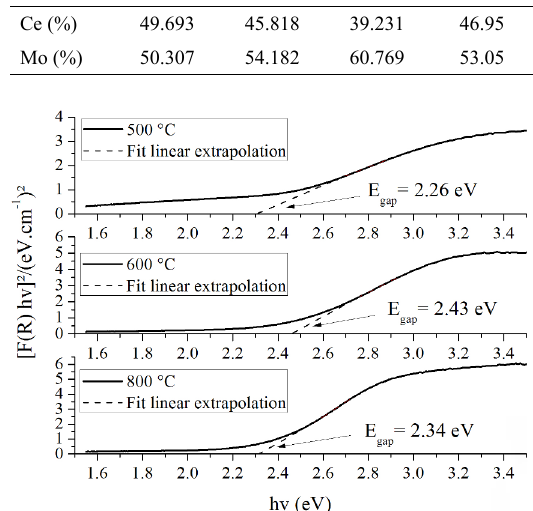
Figure 5. UV-vis absorbance spectra at room temperature for the